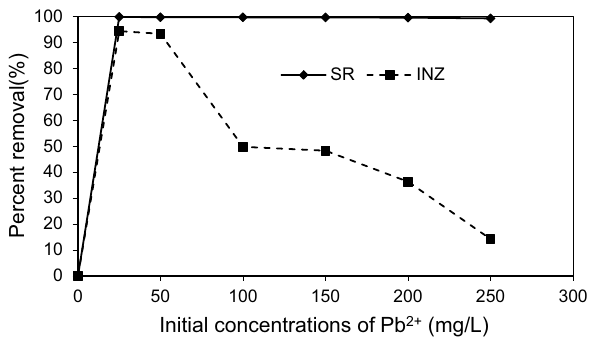
Fig. 4 Effect of contact time on Pb 2+ adsorption with INZ and SR (pH = 4.5, initial concentration = 50 mg/L, adsorbent dose: INZ = 30 g/L, SR = 10